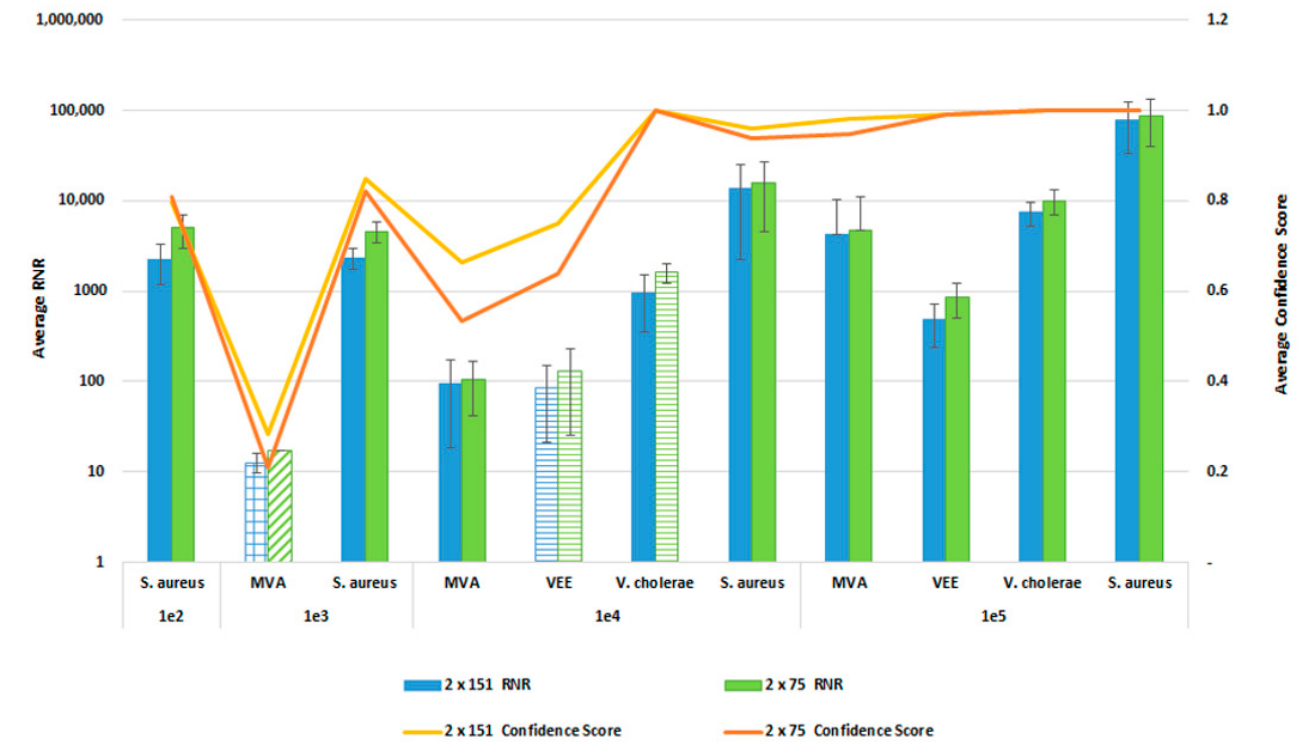
Figure 11. Sequencing Run Comparison: Environmental Samples. This figure summarizes the aver- age RNR and Confidence Scores based on 4 of 4 contrived, RBM swab replicate samples. Bars rep- resent sample RNR values and lines represent sample confidence scores. Bars with horizontal lines indicate 3 of 4 replicates detected. Bars with diagonal indicate 2 of 4 replicates detected. Bars with grid lines indicate 1 of 4 replicates detected. For this analysis, we utilized notional LoD criteria of a minimum RNR value of 100 and a Confidence Score of 0.5.